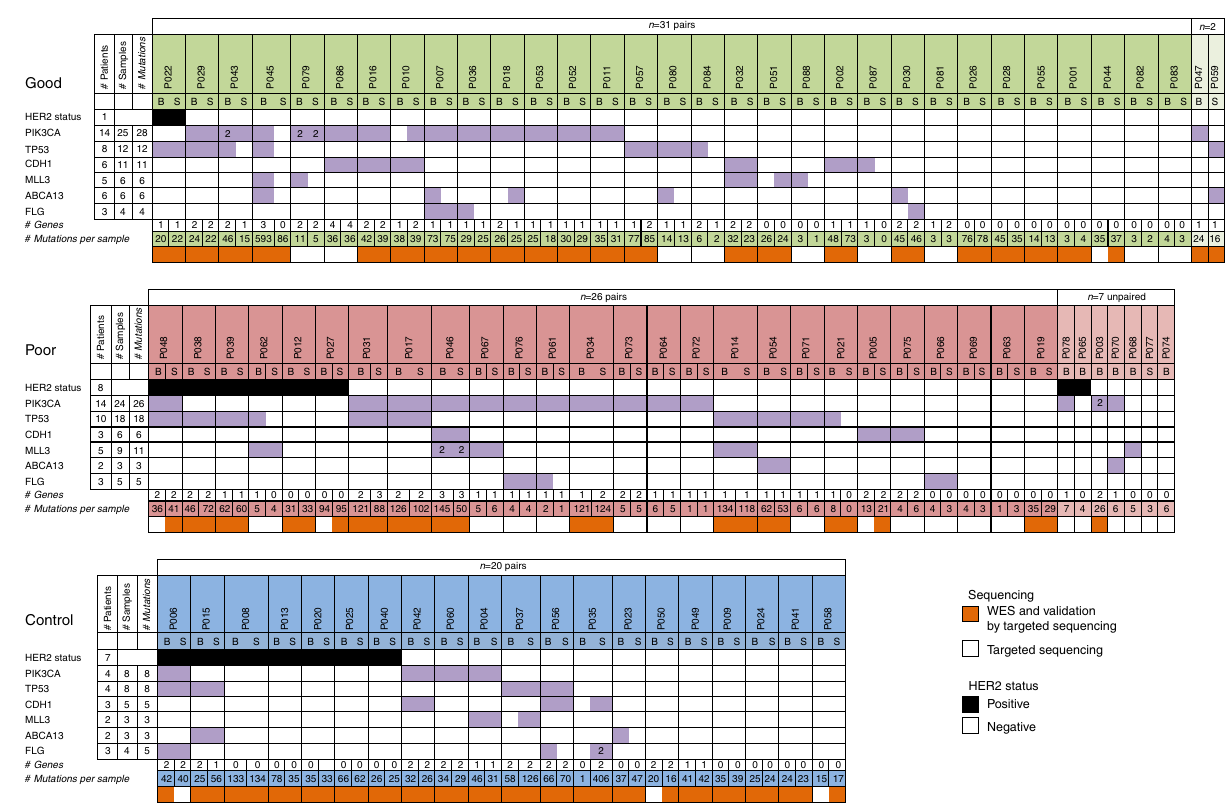
Figure 4 | Frequently mutated genes. Sample matrix for genes with mutations in 10% or more of the patients. All 163 tumour samples from 86 patients (including 77 pairs) with baseline (B) and surgery (S) sample are shown. For phase I samples, the bottom row shows if the sample successfully underwent whole-exome sequencing and therefore mutations identified in this sample were added to the capture-probe panel. The TP53 mutation of P038 and one of each mutation of MLL3 for P046 were not identical between B and S. The overall concordance between B and S samples of patients was 71%.